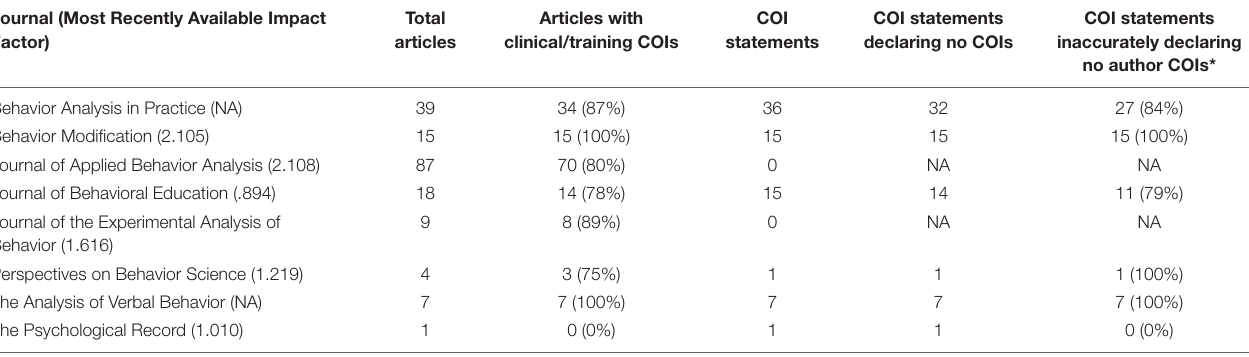
TABLE 2 | Conflict of Interest Information by Journal. Journal (Most Recently Available Impact Factor)